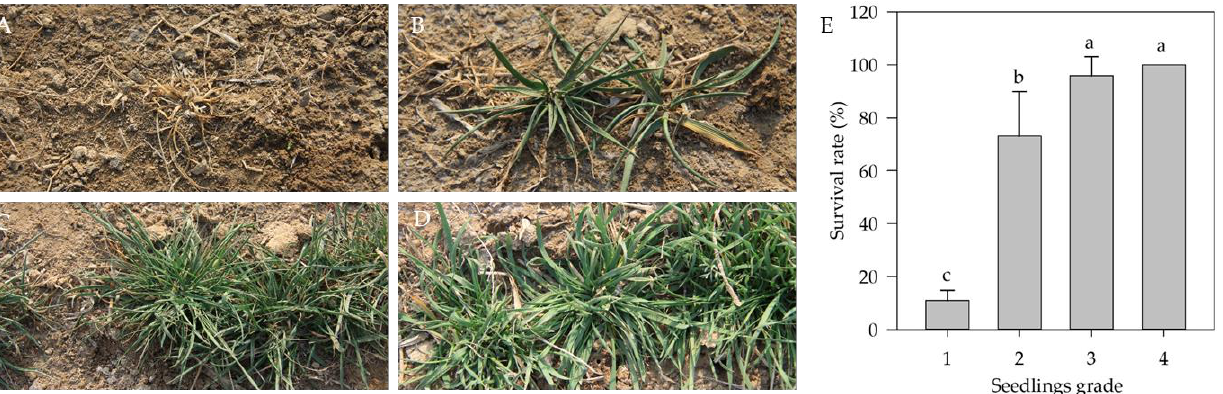
Figure 1. Photograph and survival rate of tall wheatgrass seedlings grown in saline-alkaline soils with different salinities. ( A – D ) Photographs of seedlings in grades 1–4; and ( E ) the survival rate of four seedling grades. Photographed on 11 April 2022, in Dongying, China. Data were represented as mean ± SD. Different letters indicate a significant difference at p <